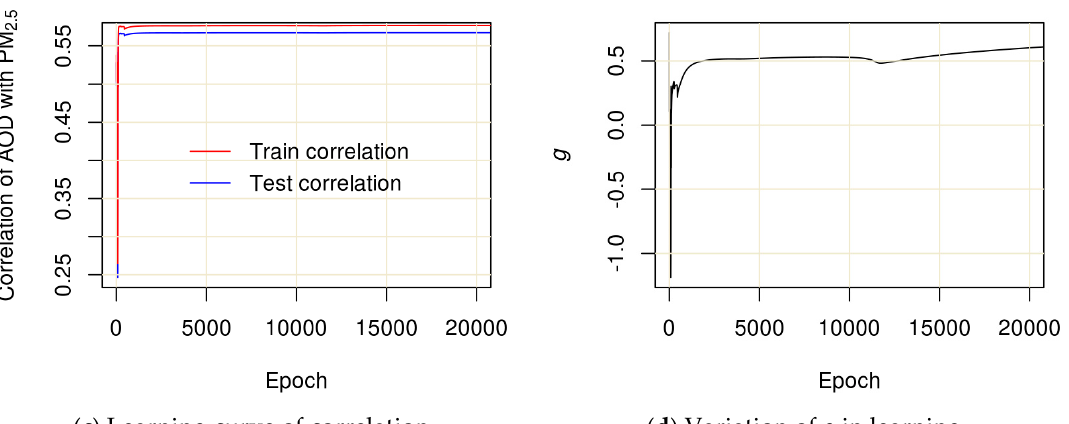
Figure 5. Trends of loss ( a ), root mean square error (RMSE) ( b ) and Pearson’s correlation with PM 2.5 ( c ) in training and testing, and g ( d ).